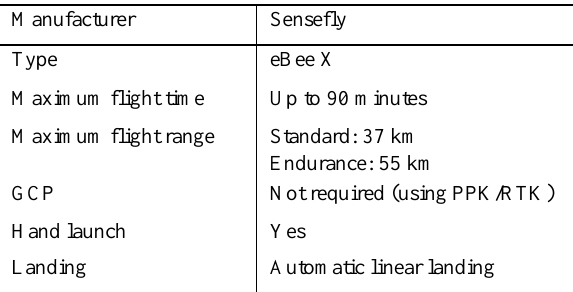
Table 1. Sensefly eBee X fixed-wing drone specifications